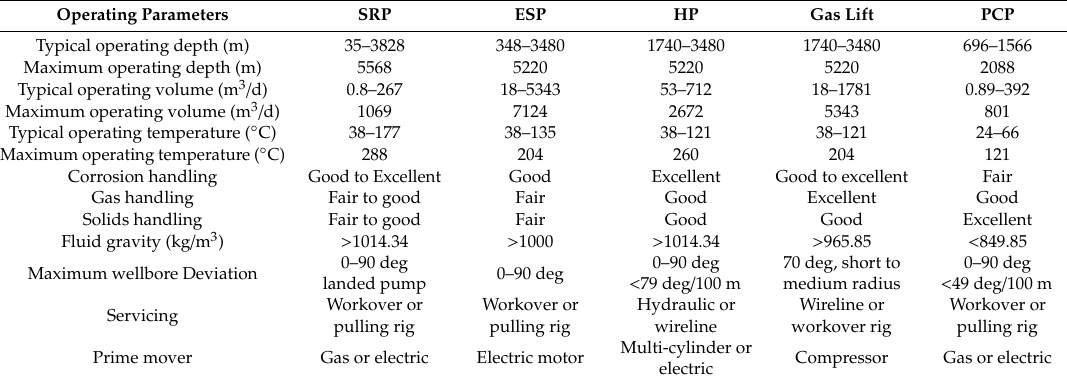
Table 2. Characteristics and limitations of the application of artificial lifting methods [16].